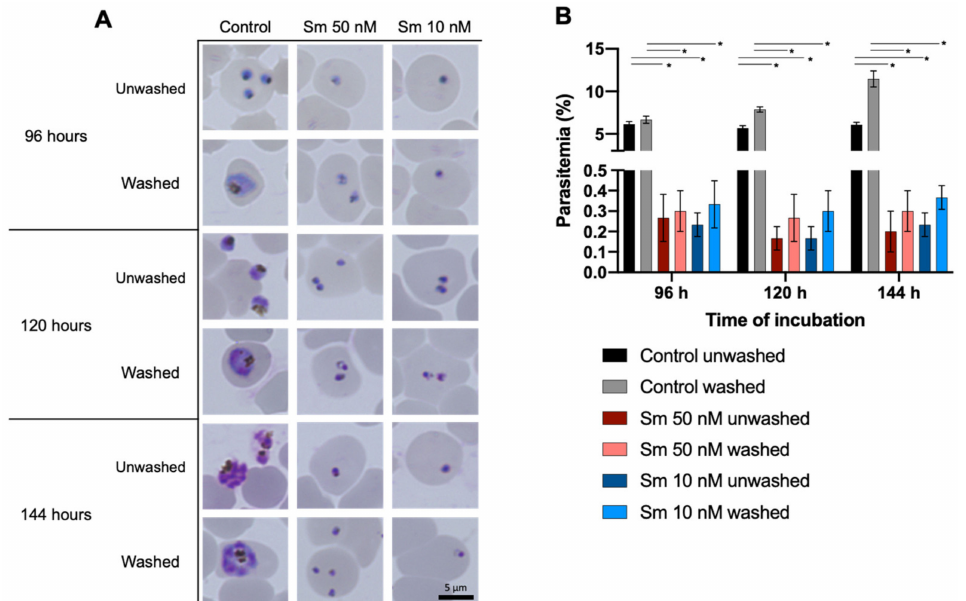
Figure 3. Representative morphologies and parasitemia levels of parasites after 72 h exposure of growth under no treatment (control) or sparsomycin (Sm) treatment (50 and 10 nM). ( A ) Parasite morphologies after 96, 120 and 144 h incubation in the presence (unwashed) or absence (washed) of Sm. All parasites in the treated group were retained in the ring stage, they were shrunken and they could not form trophozoites in the life cycle. Scale bar: 5 µ m. ( B ) Parasitemia levels after 96, 120 and 144 h of incubation in the presence (unwashed) or absence of Sm (washed). Parasitemia levels are presented as the mean of triplicate experiments and the error bars represent standard deviations. The significance of differences in the level of parasitemia of Sm-treated cultures compared with control were analyzed by two-way ANOVA and a Tukey’s multiple comparison test (*, significant at p <